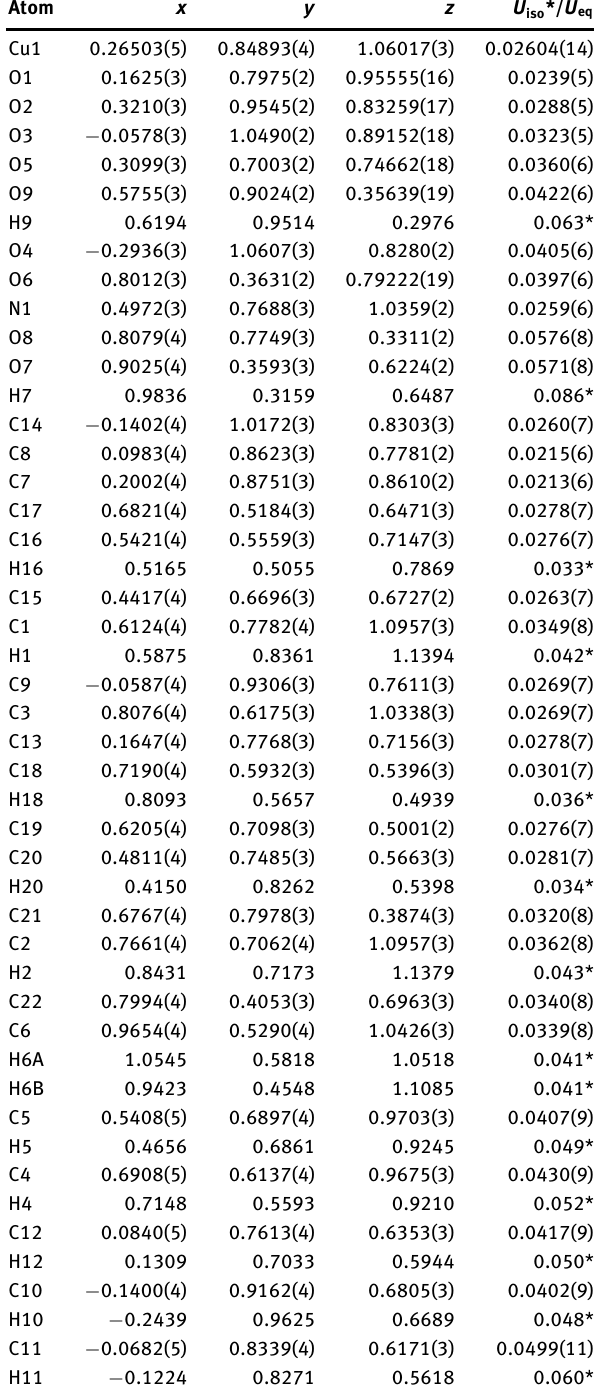
Table 2: Fractional atomic coordinates and isotropic or equivalent isotropic displacement parameters (Å 2